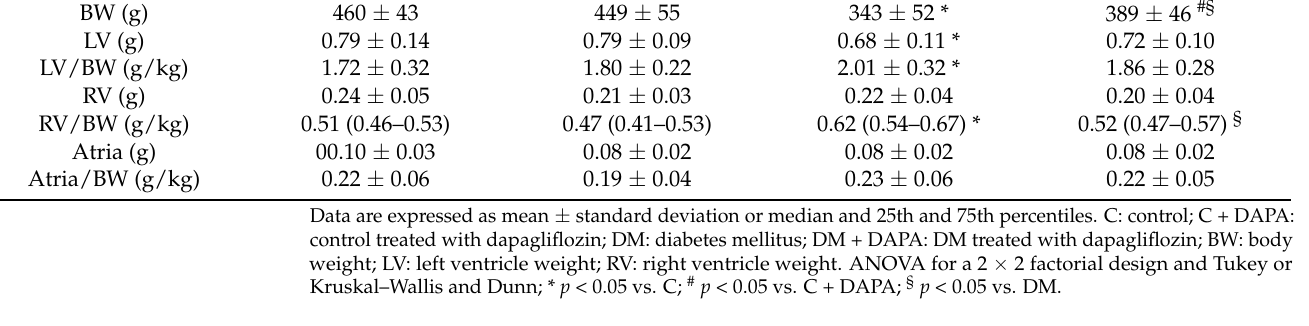
Table 6. Myocardial hydroxyproline (HOP) concentration and left ventricular morphometric parameters.